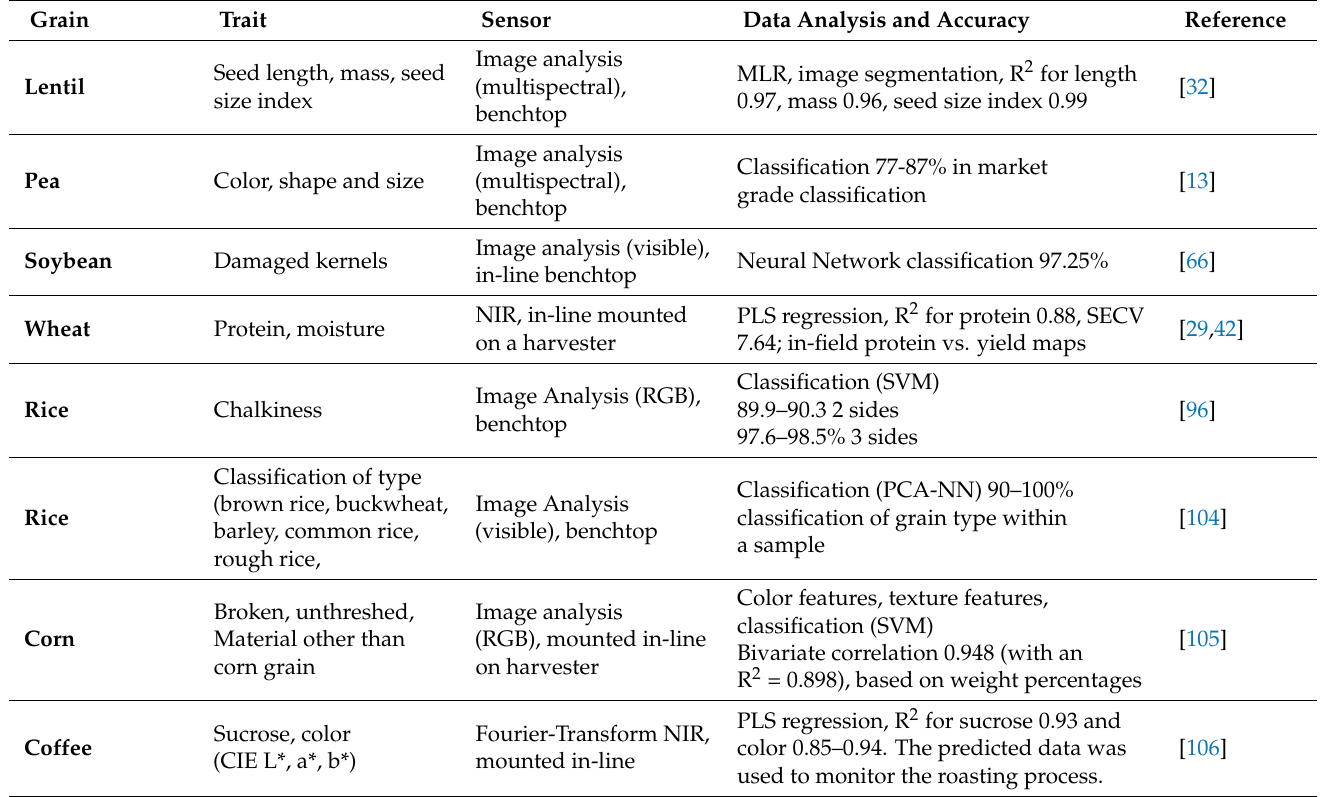
Table 2. Current sensor technologies applied to grains and seeds measured in-line for a range of quality